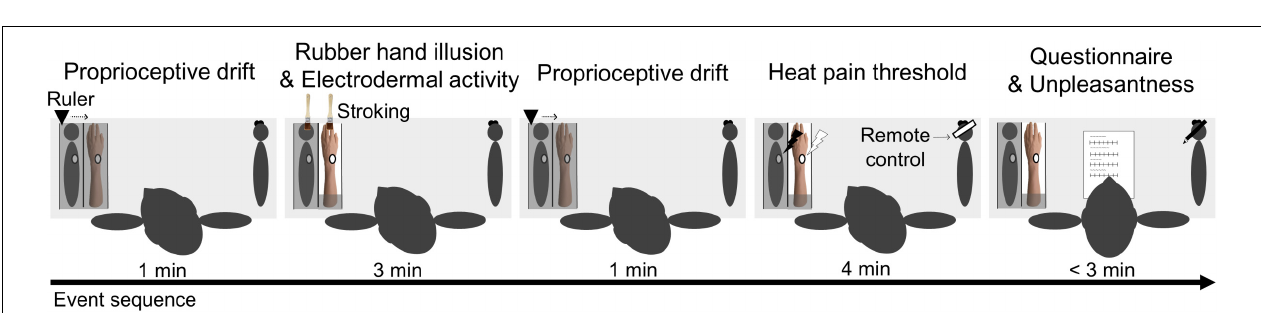
FIGURE 2 | Experiment 1 procedure: (1) proprioceptive drift measurement (pre-RHI); (2) RHI and EDA; (3) proprioceptive drift measurement (post-RHI); (4) HPT measurement; and (5) questionnaire and unpleasantness measurement.